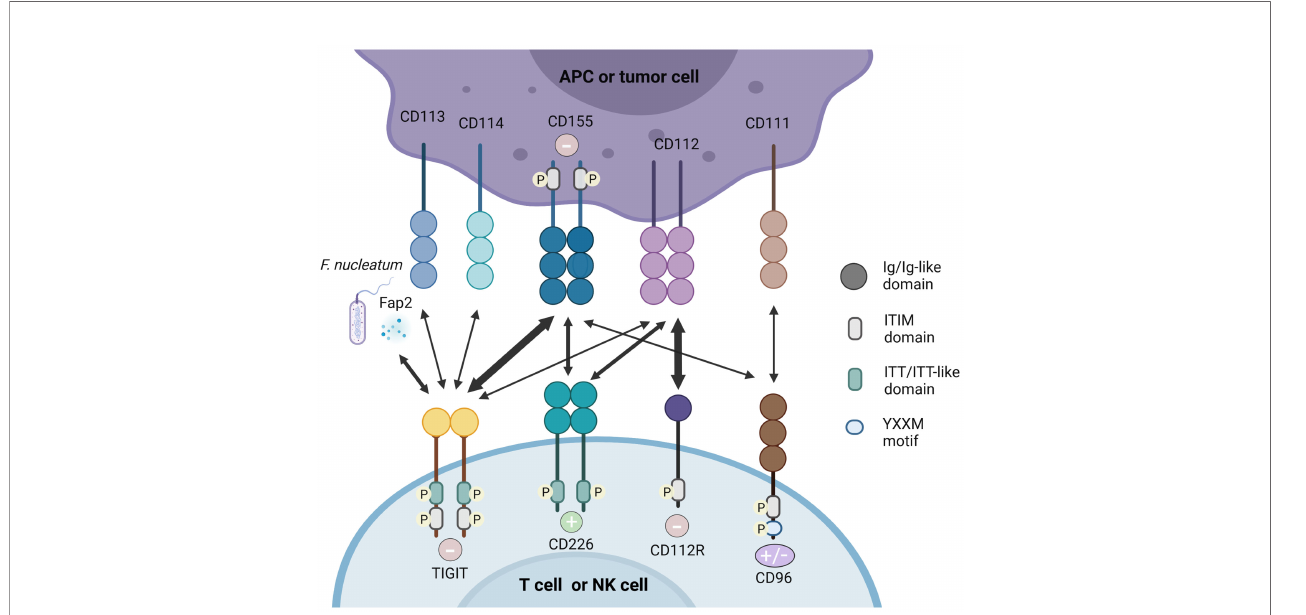
FIGURE 1 | TIGIT/CD226 pathway axis. TIGIT, CD226, CD112R, and CD96 are expressed on activated T cells and NK cells. Their respective ligands, CD155, CD112, CD113, CD114, and CD111 are expressed on APCs or tumor cells. The Fap2 protein released by F. nucleatum is also identi fi ed as ligand for TIGIT. TIGIT, CD155, and CD112R which contain ITIM motifs in their cytoplasmic tail trigger inhibitory signals ( – ) to cells, while CD226 binds to CD155 and CD112 delivering an activating signal (+). CD96 contain ITIM, but human CD96 also contains an YXXM motif. Therefore, whether CD96 elicits a positive or negative signal in human T cells remain to be demonstrated. High af fi nity binding between receptors and their respective ligands are illustrated with heavy arrows, for example, the interaction between TIGIT and